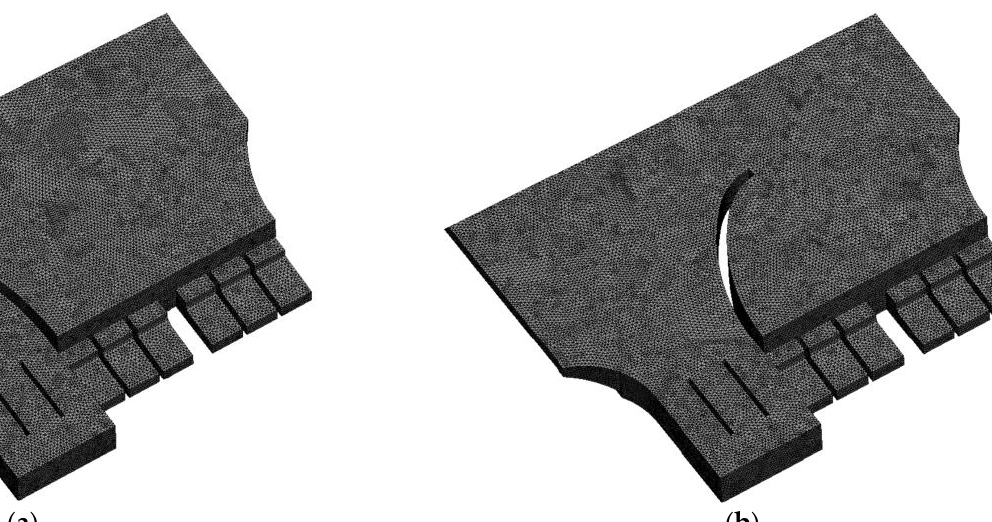
Figure 7. Grid independence calculation diagram.